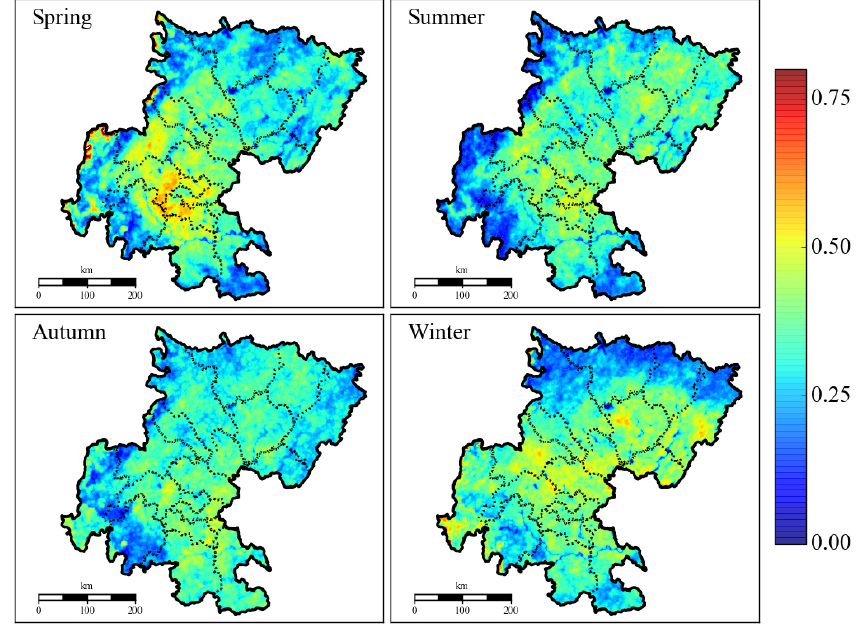
Figure 3. Spatial and temporal distributions of retrieved AOD from 1 km MODIS data over the Sichuan Basin.